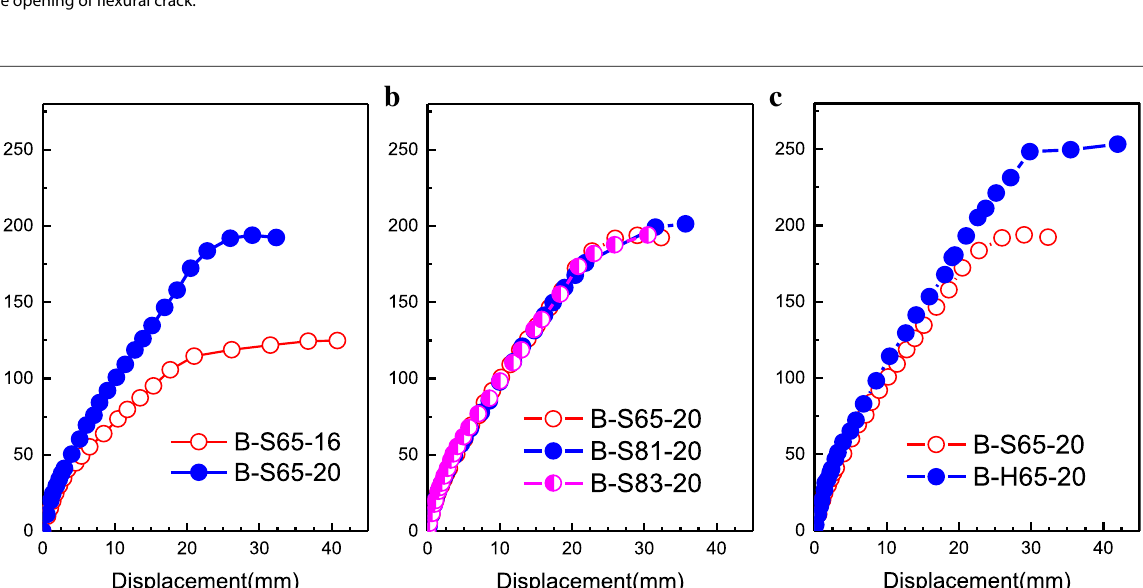
Δ cr deflection at first cracking load, P cr = Δ u ultimate deflection and P u = a Yielding of steel rebars.